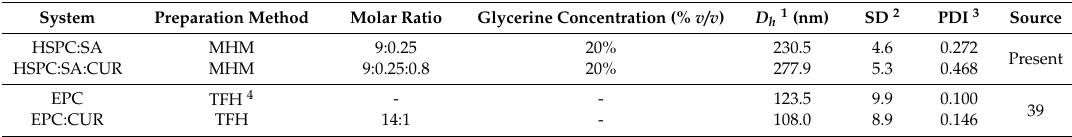
Table 5. The physicochemical properties of lipidic vehicles with incorporated curcumin developed through the MHM and the thin-film hydration method (TFH) method.